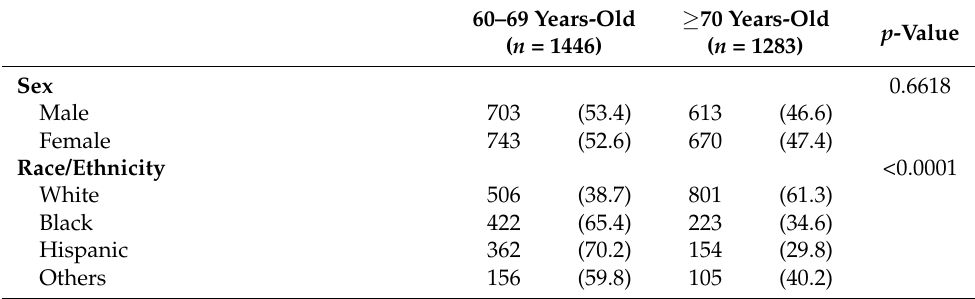
Table 1. Characteristics of the study population according to age